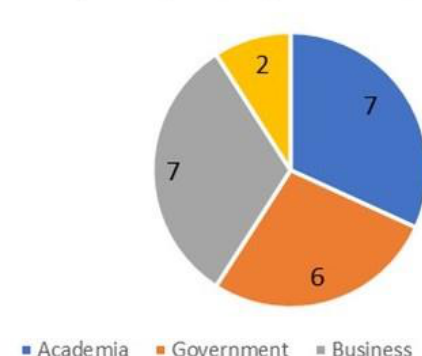
“ business ” , and one person having a double function “ government ” and “ business ” . Left chart including students, right